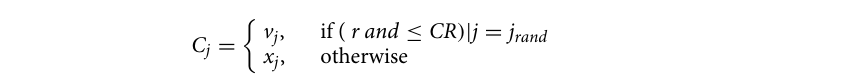
Figure 3. Comparison between the return loss before and after the mode optimization